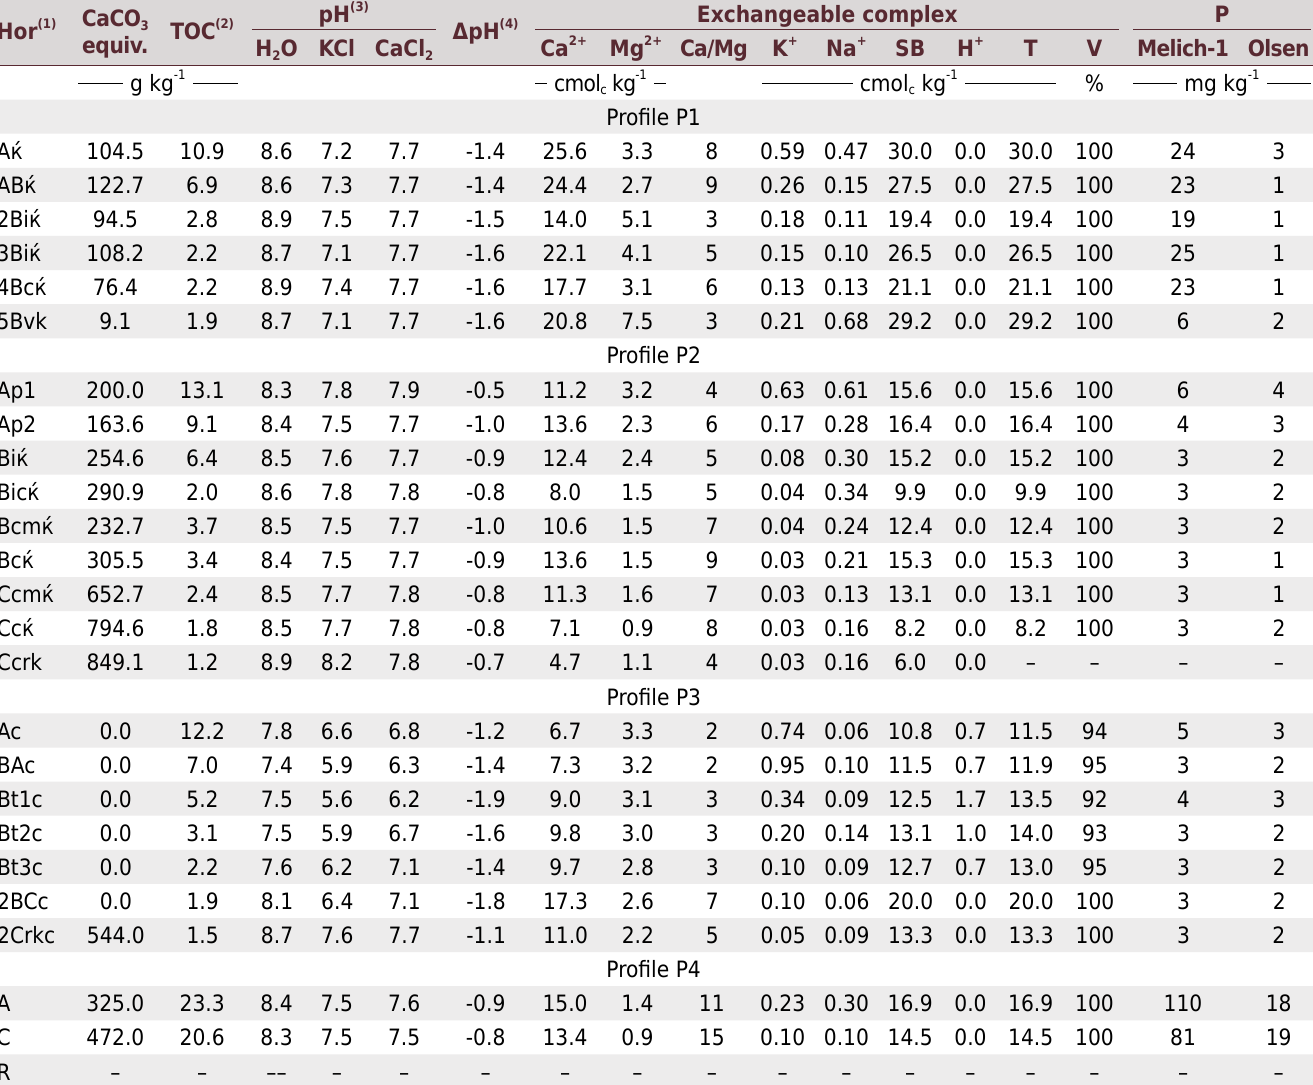
Table 2. Calcium carbonate (CaCO 3 ) equivalent, organic carbon level, pH, chemical properties, and phosphorus of soils from the Apodi